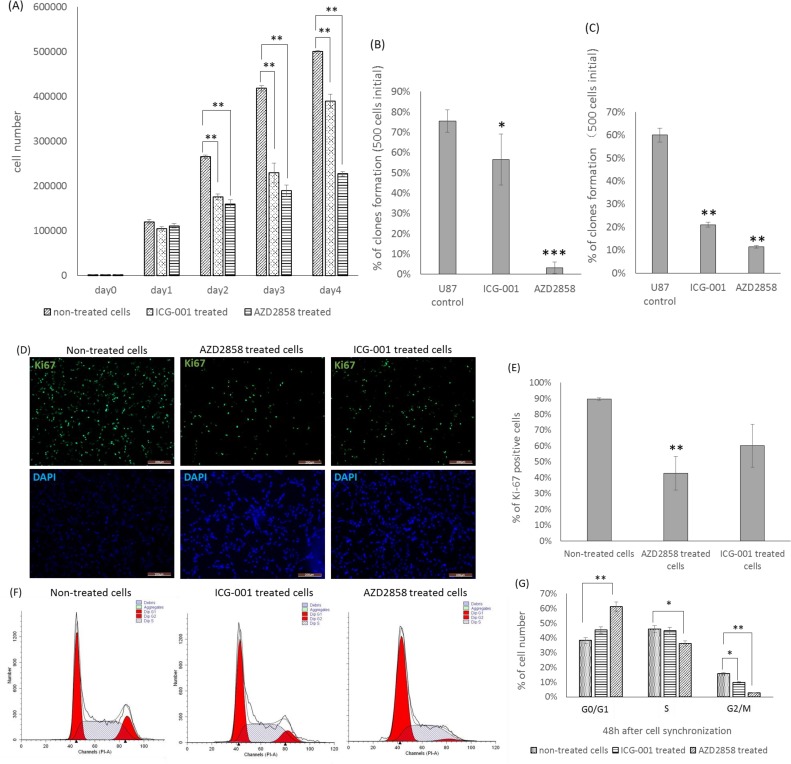
Effects of ICG-001 and AZD2858 on cell proliferation, colony formation and cell cycle of U87 glioma cells.(A) Cell viability for each media condition. (B) Percentage of single colony forming under different media condition. (C) Single colony forming of ICG-001 treated cells, AZD2858 treated cells and control cells under the same media condition. (D) Ki67 expression (green) in each groups. (E) Percentage of Ki67 positive cells. (F) Cell cycle of AZD2858 treated cells, ICG-001 treated cells and control. (G) Percentage of cells in G0/G1 phase, S phase and G2/M phase, 48 hour after cell synchronization. * means p < 0.05; ** means 0.001<p < 0.01; *** means p < 0.001.